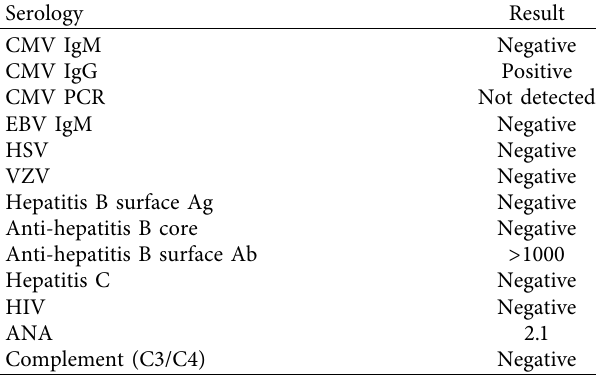
Table 1: Patient’s laboratory results prior to renal